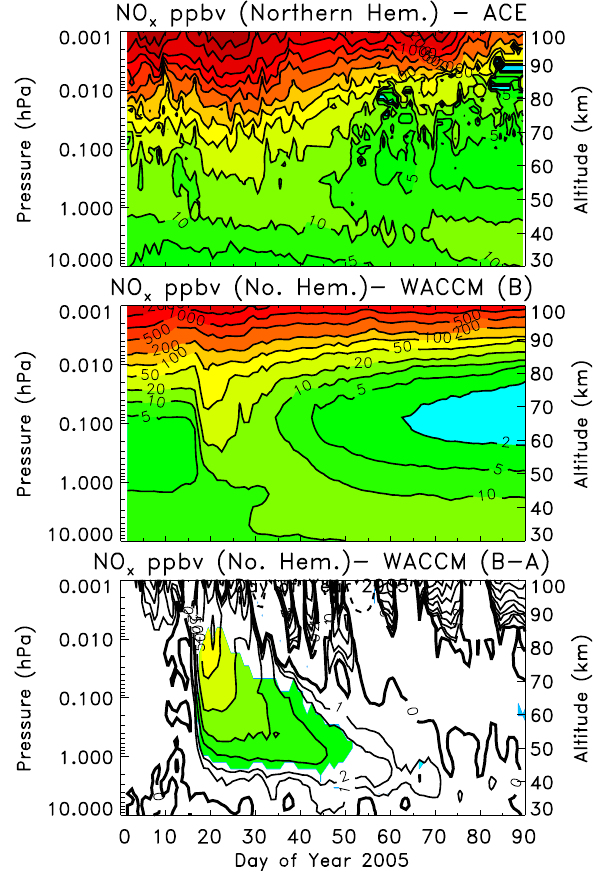
Fig. 13. Daily averaged SCISAT-1 ACE measurements (top) and WACCM3 predictions (middle, bottom) for NO x during the first 90 days of 2005 (1 January–31 March) for the high latitude Northern Hemisphere. The WACCM3 NO x predictions (middle) are from an average of the B realizations and the WACCM3 NO x predictions (bottom) show the NO x enhancement due to the SPEs (an average of the B realizations minus an average of the A realizations). The colored regions indicate 95% statistical significance with the use of Student’s t test. The contour intervals are 1, 2, 5, 10, 20, 50, 100, 200, 500, 1000, 2000, 5000, and